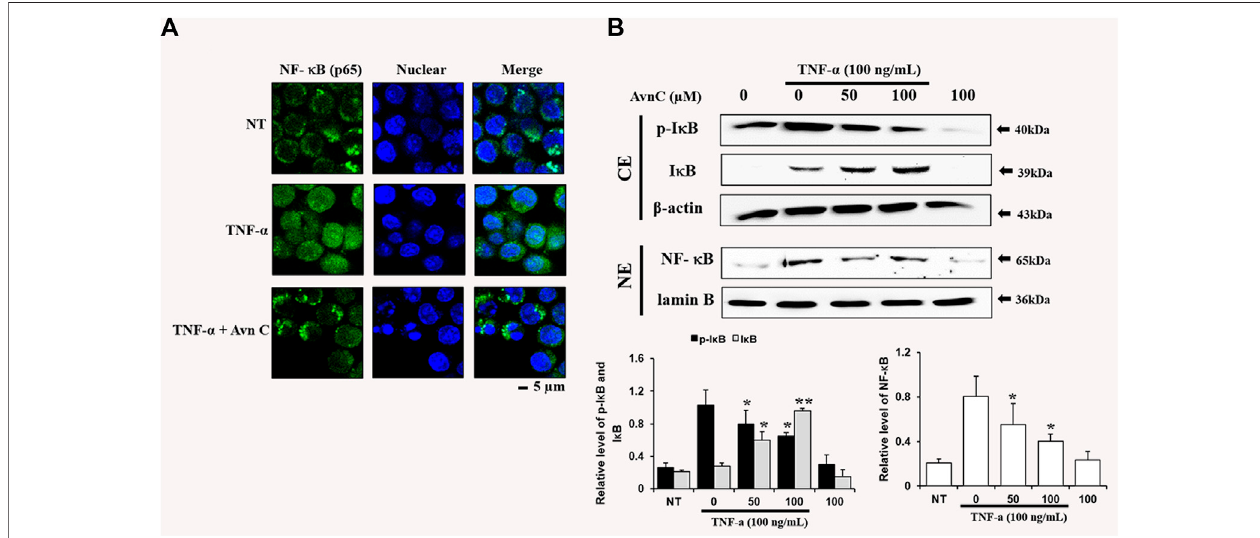
FIGURE 5 | Effects of Avn C on TNF- α -induced nuclear translocation of NF-kB in HASMC cells (A) Transfer of NF- κ B to the nucleus was detected by immuno fl uorescence assay. HASMC cells were immune-stained by FITC and Hoechst. Scale bars, 5 μ m. NE, Nuclear extracts; CE, Cytosolic extract; NT, no treatment (B) NuclearextractsweresubjectedtotranslocationtothenuclearregionoftheNF- κ BsubunitbyWesternblot.Theyarepresentedasmean ± SEM.* p < 0.05and** p < 0.01, signi fi cant differences from the TNF- α treated cells. NT, no treatment.